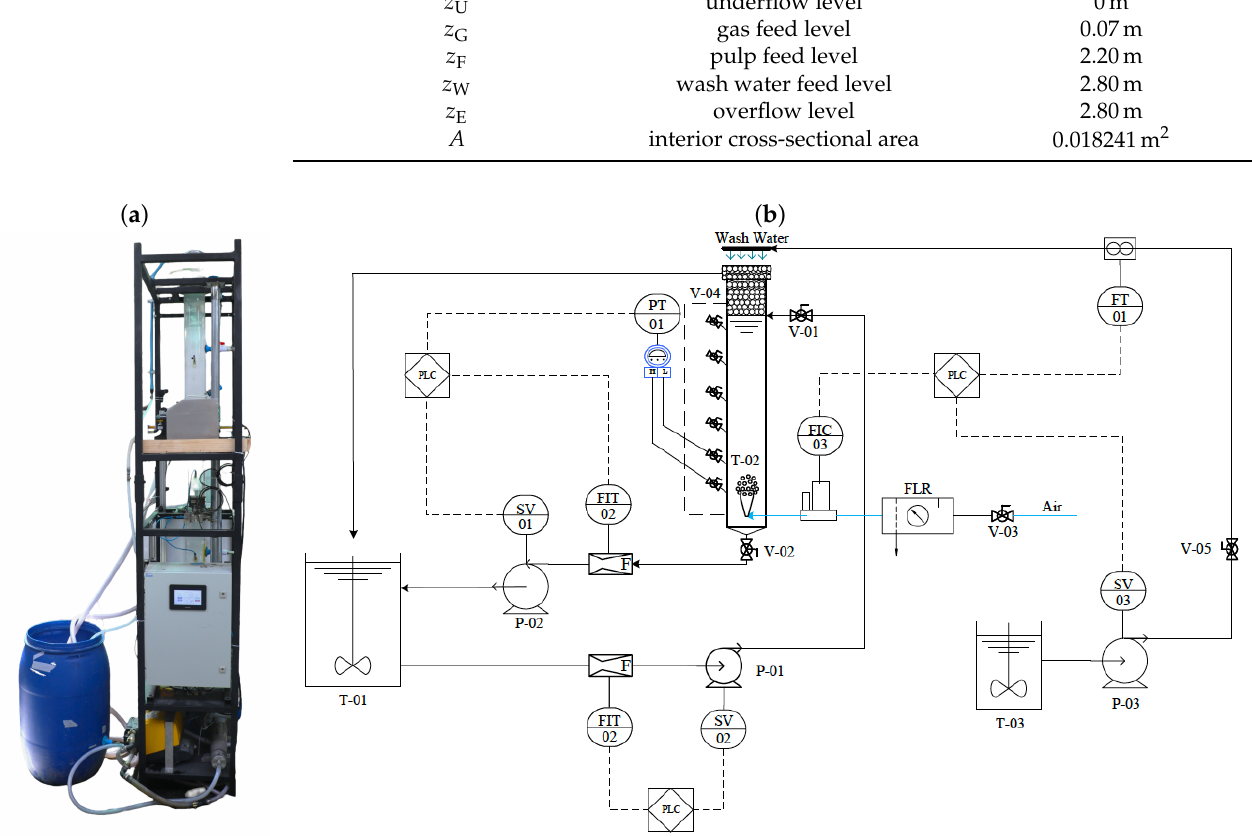
Figure 2. ( a ) Photograph of the laboratory column and ( b ) schematic of the piping and instrumenta- tion devices (P & ID). See Table 2 for